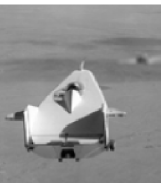
Figure 4. Autofocusing and fusion algorithm handling method.